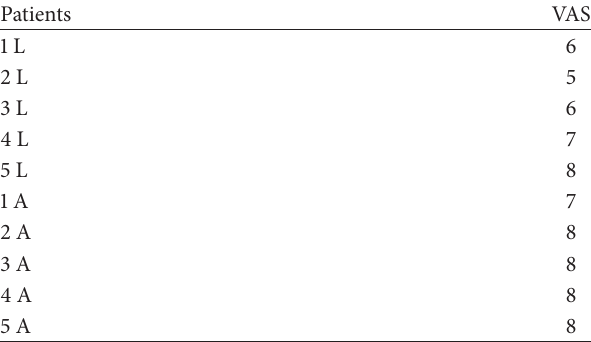
Table 4: Visual Analogic Scale (VAS). Score ranging from 1 to 10, whereby 1 indicates no improvement and 10 the maximum possible